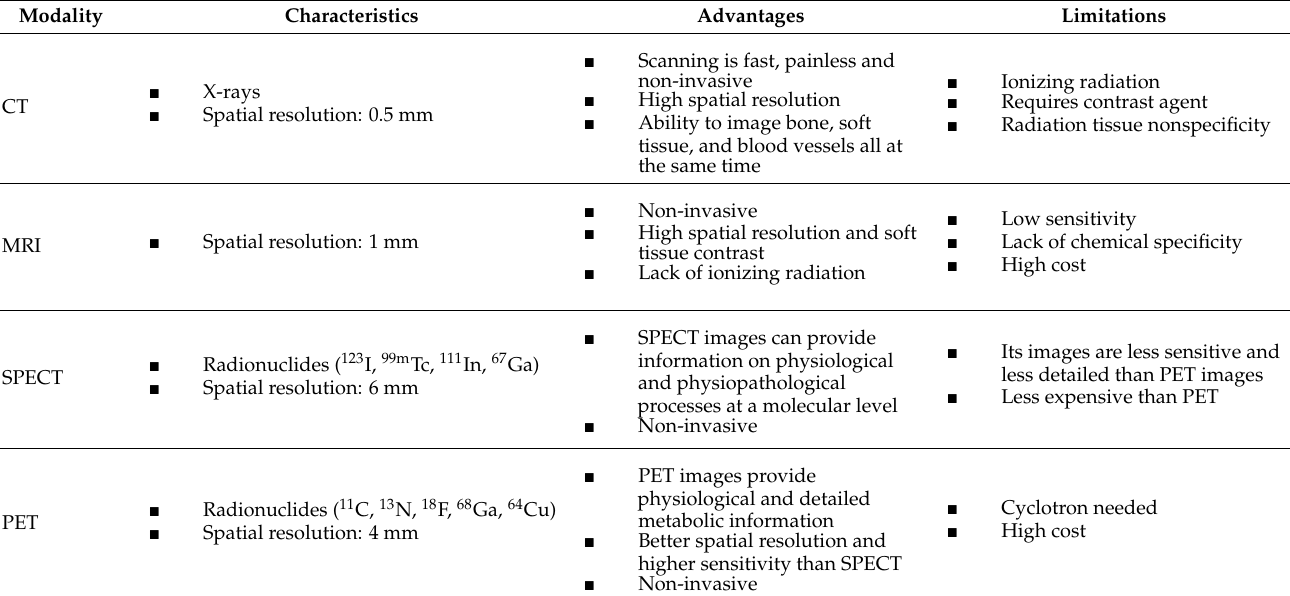
Table 1. Properties and characteristics of the following imaging modalities: CT, MRI, SPECT and